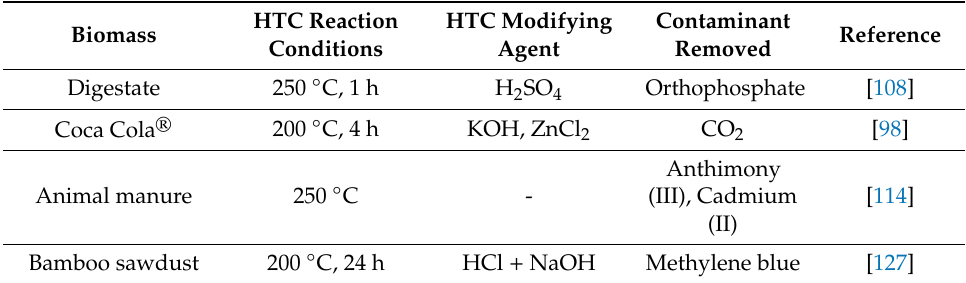
Table 3. Biomass type and HTC condition for removal of contaminants from waste